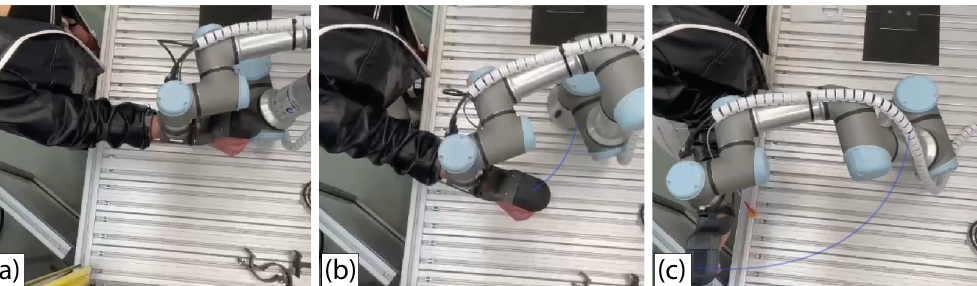
Figure 8. Top view of the Lateral Shoulder Rotation exercise performed by the UR3 robot. ( a ) Begin- ning of the repetition. ( b ) Middle of the repetition. ( c ) Reaching the limit of the patient’s admissible range of motion. Blue line represents the path followed by the robot [38].